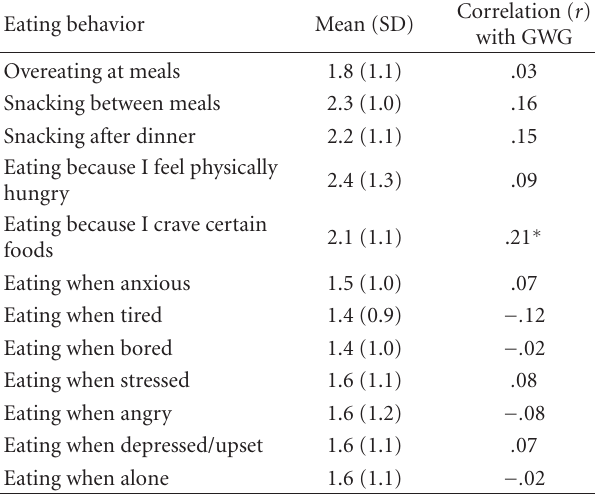
Table 2: Attributions for the influence of eating habits on weight gain during pregnancy and their Pearson correlations with ges- tational weight